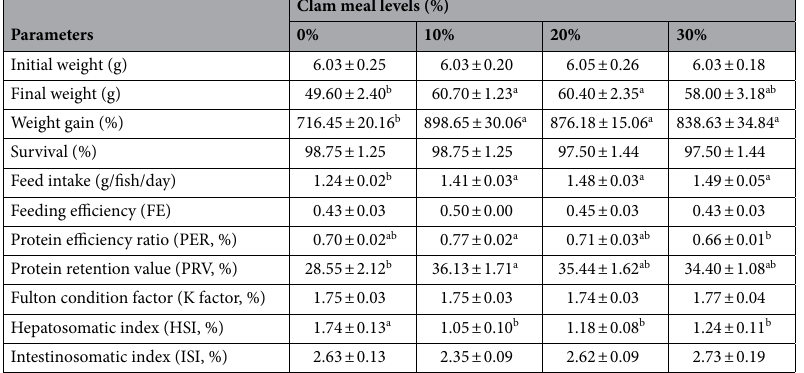
Table 4. Growth performance, feed utilization and organ indices. a,b Mean values within a row with unlike superscript letters were significantly different ( P < 0.05).